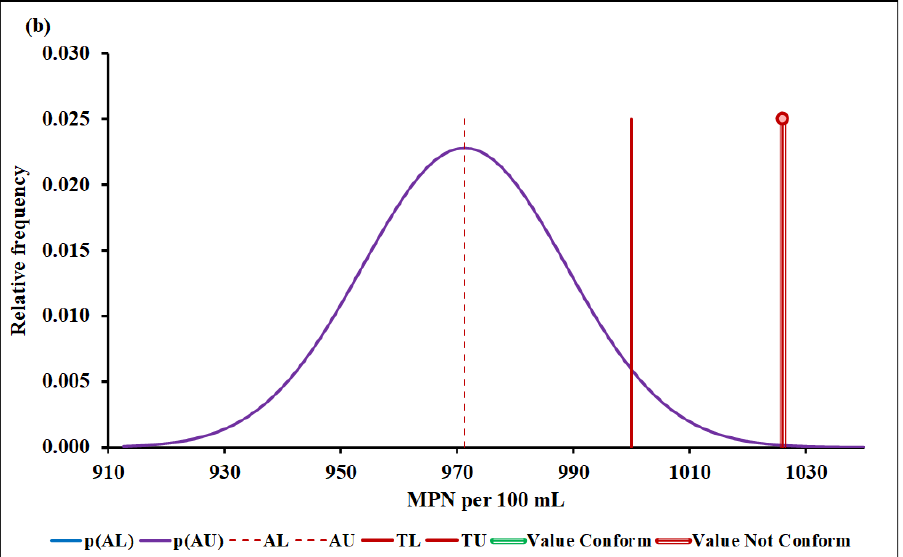
Figure 6. Escherichia coli conformity assessment based on ( a ) MADe approach and ( b ) nIQR approach. p(AL)—probability density at the lower acceptance limit; p(AU)—probability density at the upper acceptance limit; AL—lower acceptance limit; AU—upper acceptance limit; TL—lower tolerance limit; TU—upper tolerance limit.